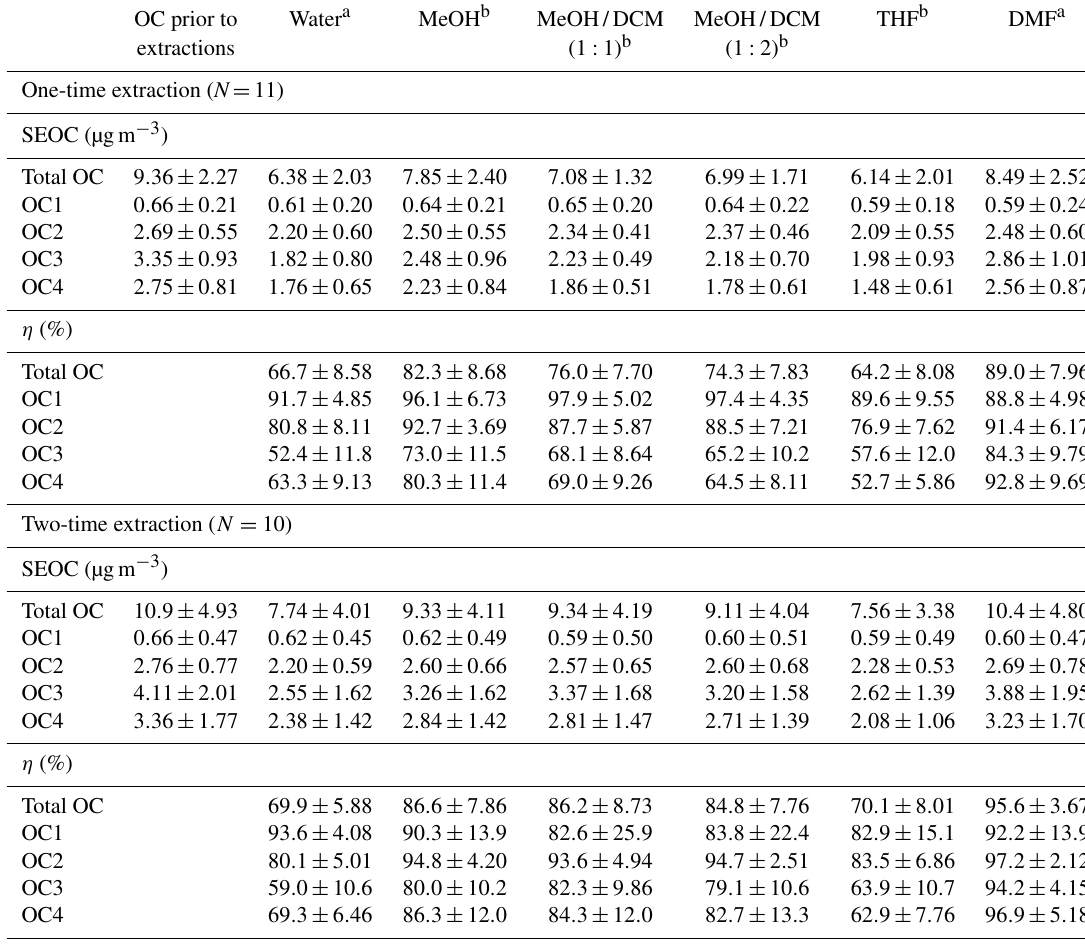
Table 1. SEOC concentrations and extraction efficiencies ( η , %) of total OC and OC fractions for different solvents. OC prior to Water a MeOH b MeOH/DCM MeOH/DCM THF b DMF a extractions (1 : 1)